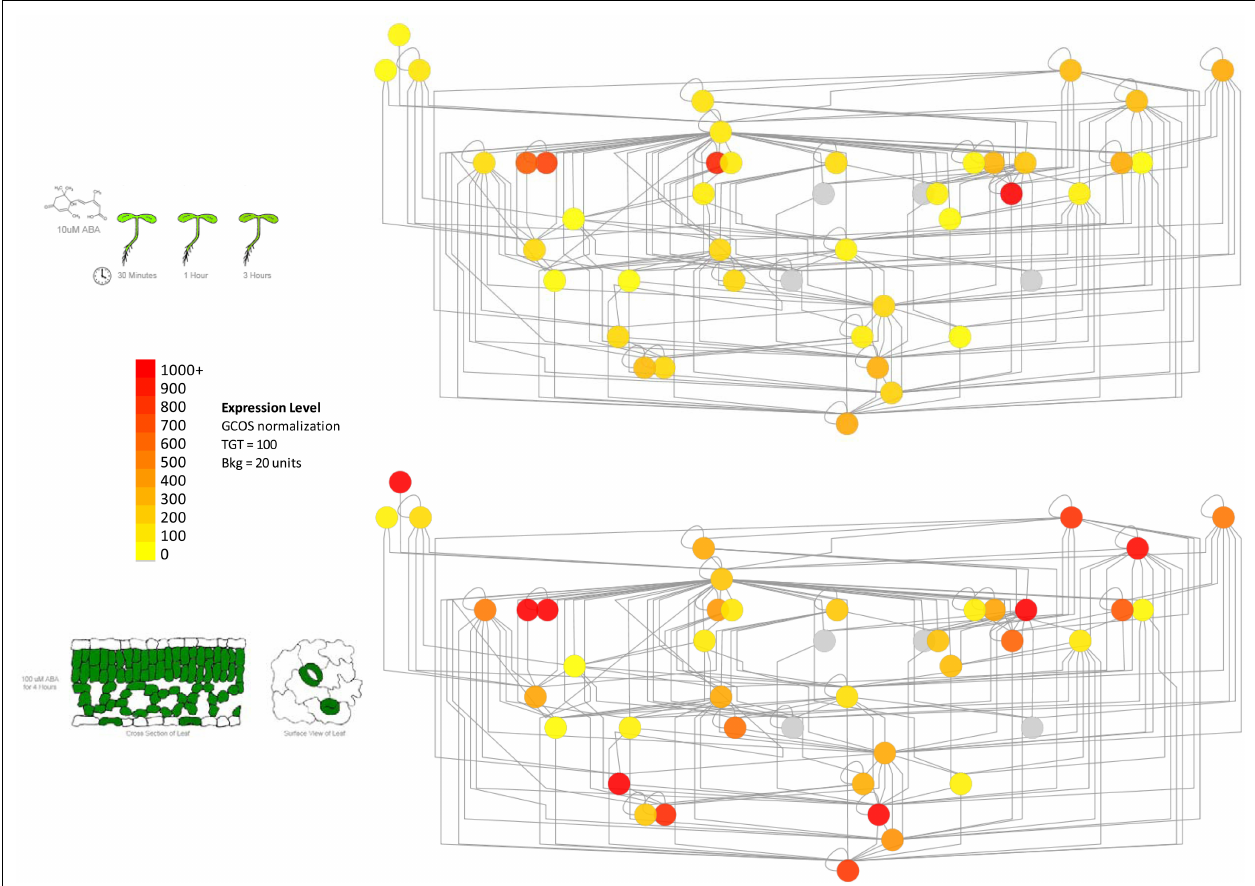
FIGURE 2 | Using gene expression data to delineate subnetworks within larger protein–protein interaction networks determined by the yeast two hybrid method. Left panel: part of the vesicle trafficking PPI interactome, with nodes colored according to average expression level of the corresponding genes in seedling tissue (root and shoot) treated with 10 μ M ABA (Goda etal., 2008). Right panel: the same network colored according to